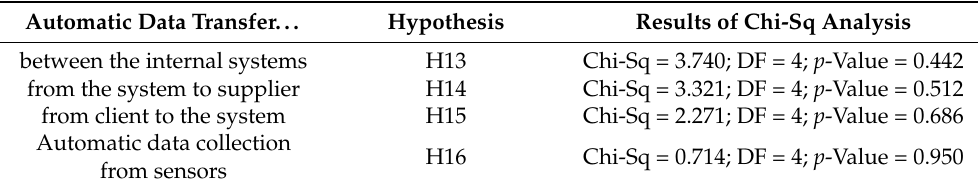
Table 5. Results of Chi-Sq analysis for automatic data transfer depending on production type. Automatic Data Transfer...